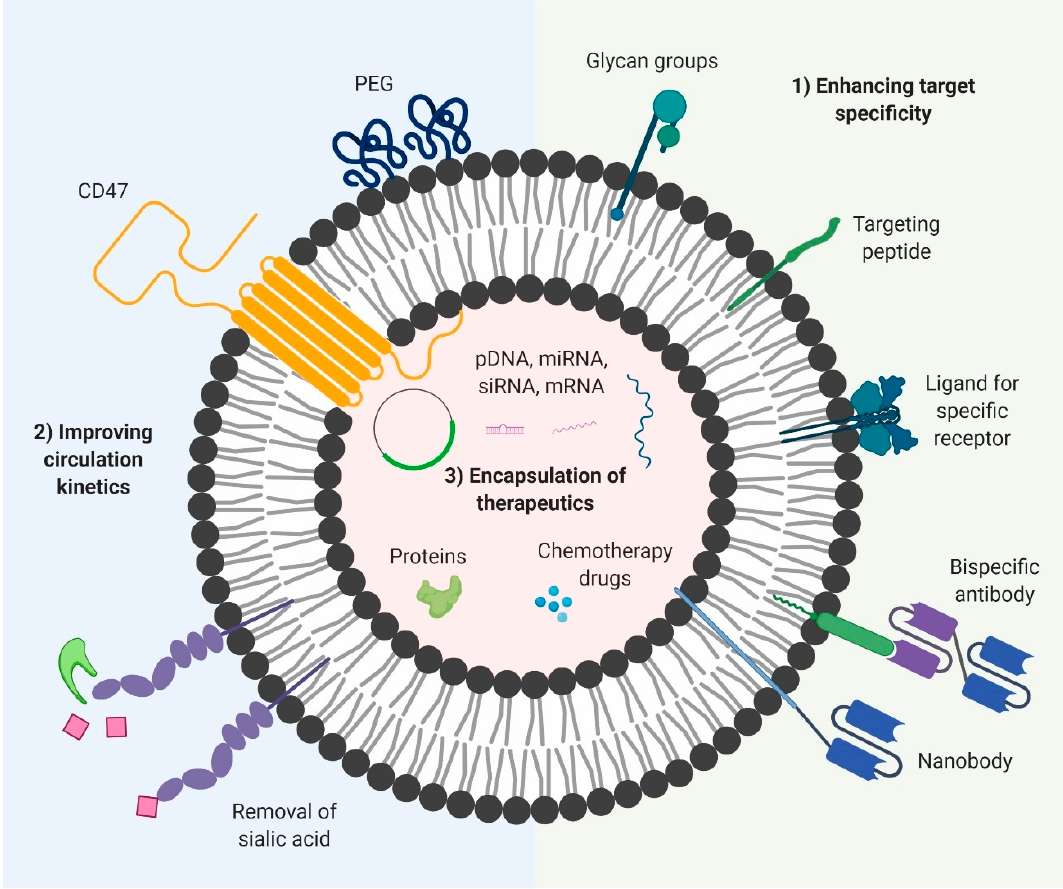
Figure 2. Summary of modifications used to increase therapeutic efficacy of EV-based therapeutics. ( 1 ) Incorporation of various targeting moieties (nanobodies, bispecific antibodies, peptides) to target specific antigens on target cells or glycan groups/ligands that can bind to receptors on target cells. ( 2 ) Addition of CD47, PEG or removal of sialic acid to reduce clearance by macrophages of the RES. ( 3 ) Encapsulation of nucleic acids (plasmid DNA, mRNA, miRNA, siRNA), therapeutic proteins and small molecule drugs which are then delivered to target cells to carry out their therapeutic effects.